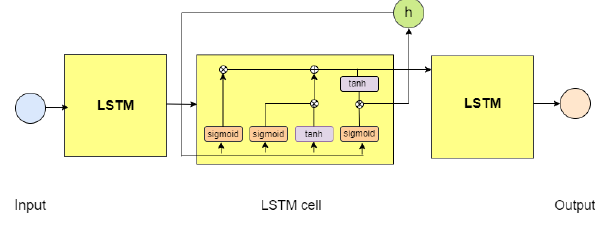
Figure 4. A generalized LSTM feature [33].